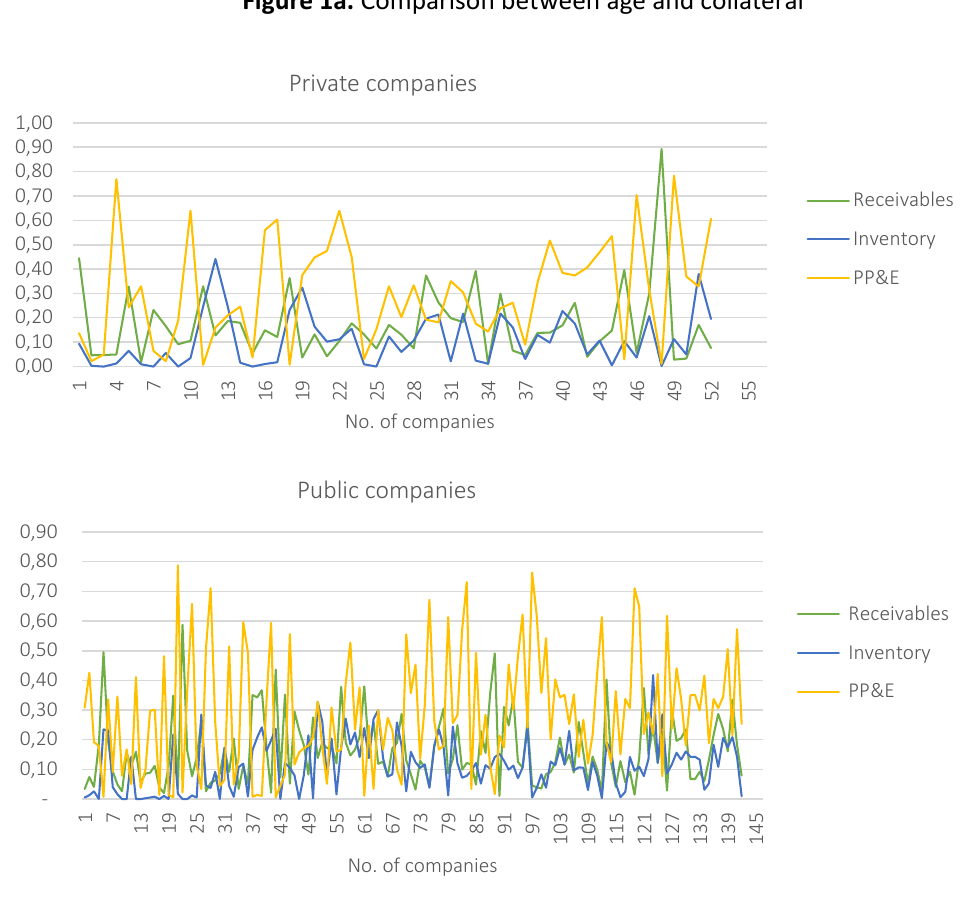
Figure 1a. Comparison between age and